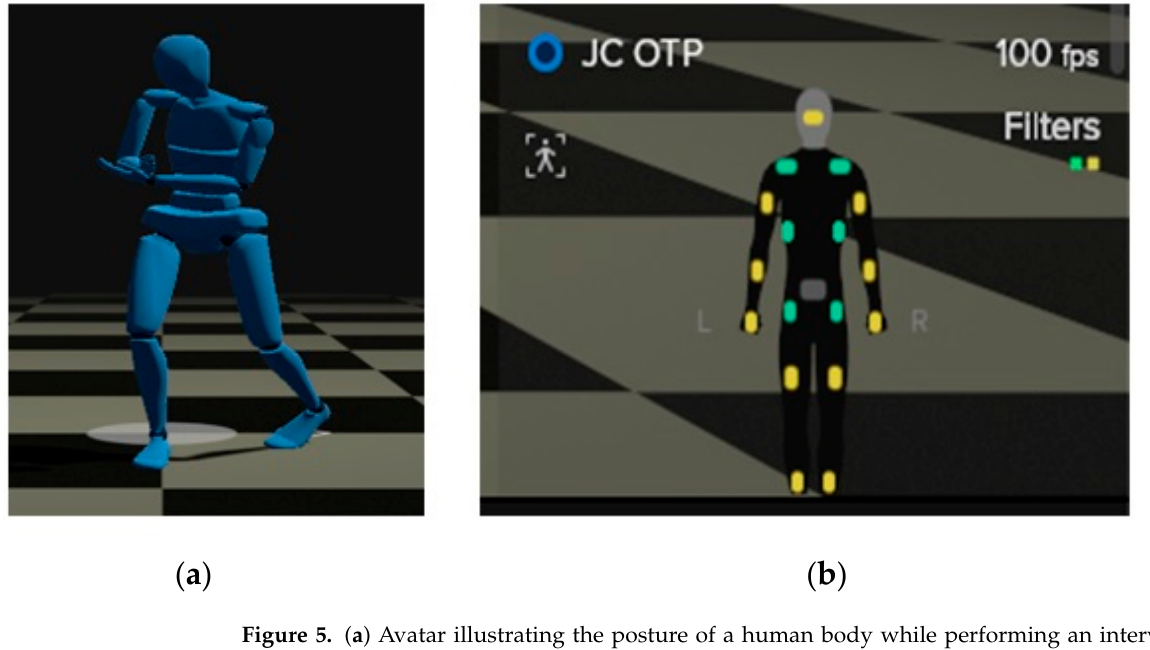
Figure 5. ( a ): Avatar illustrating the posture of a human body while performing an intervention technique. ( b ): arrangement of the wireless sensors on a human body.